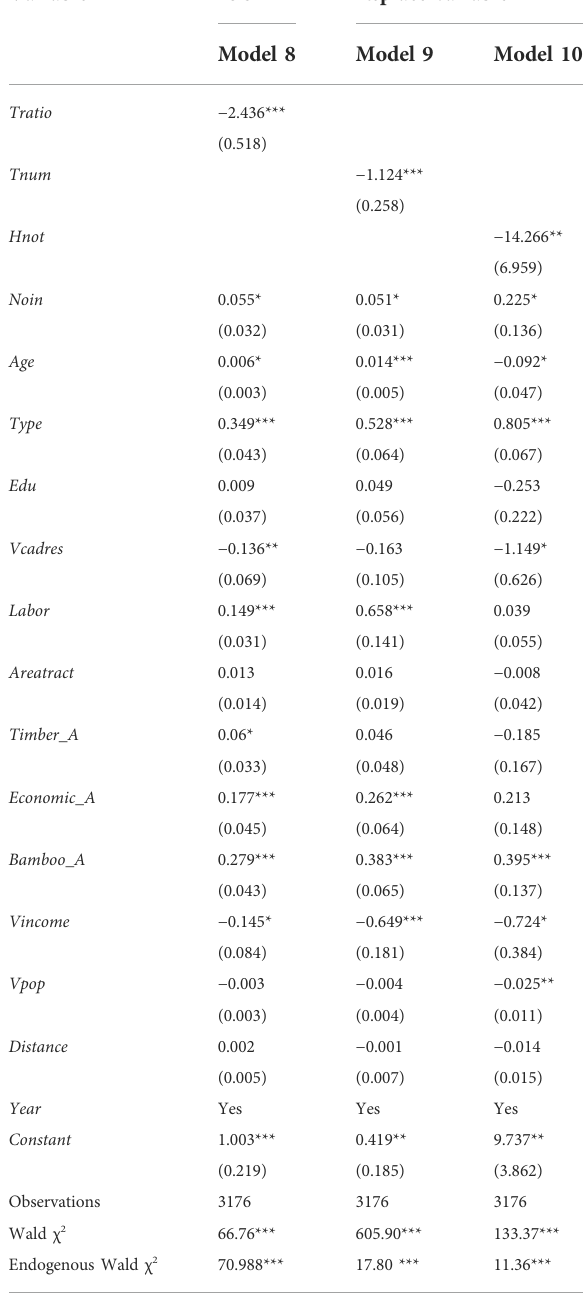
TABLE 3 Test of the robustness of the benchmark